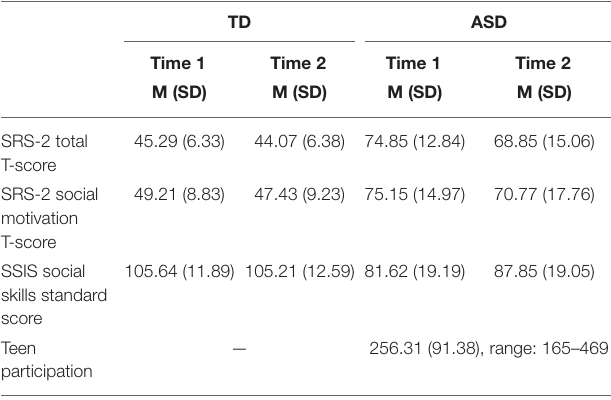
TABLE 2 | Mean scores on behavioral measures in TD and ASD participants at Time 1 and Time